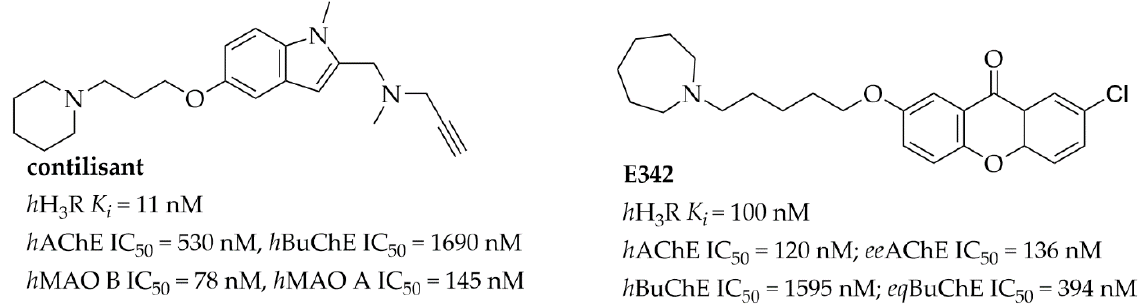
Figure 2. Structures and biological activity of selected multi-target histamine H 3 receptor ligands.